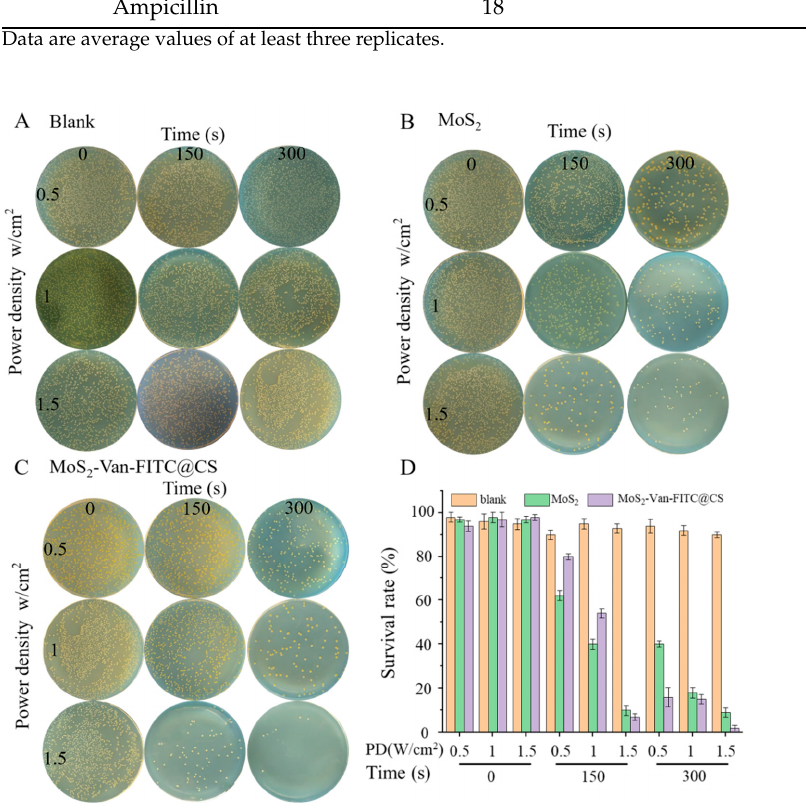
Figure 4. In vitro antibacterial activity. ( A ) The results of the CFU assay for the blank group. PBS as a blank group. ( B ) The results of the CFU assay for MoS 2 (100 µg/mL) for different times (0, 150 and 300 s) at different power densities (0.5, 1 and 1.5 W/cm 2 ). ( C ) The results of the CFU assay for MoS 2 - Van-FITC (100 µg/mL) for different times (0, 150 and 300 s) at different power densities (0.5, 1 and 1.5 W/cm 2 ). ( D ) Quantitative statistical results of ( A – C ) (PD = Power Density). graphed using the Origin software. Results shown are mean ± SD, n = 3.